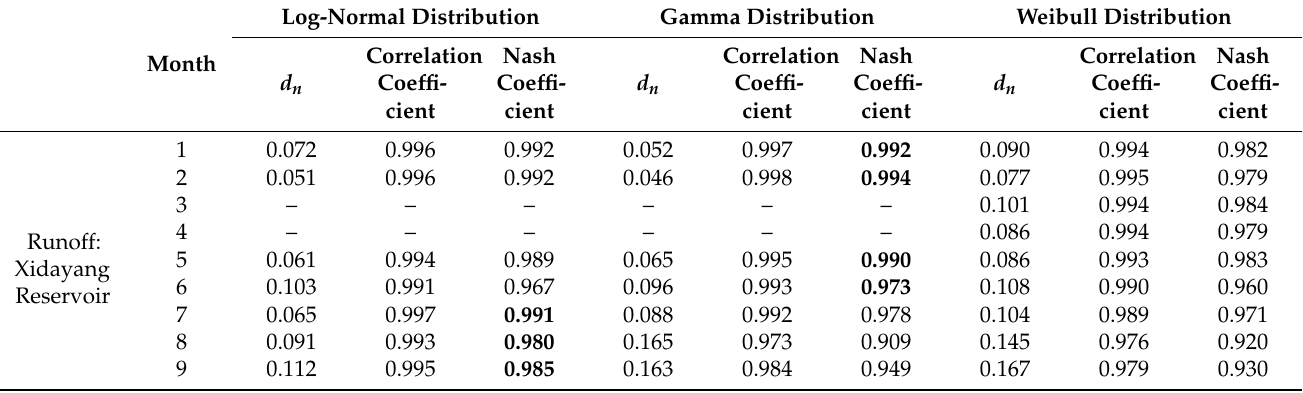
Table 3. Goodness-of-fit results for the runoff and water level data fitted to three